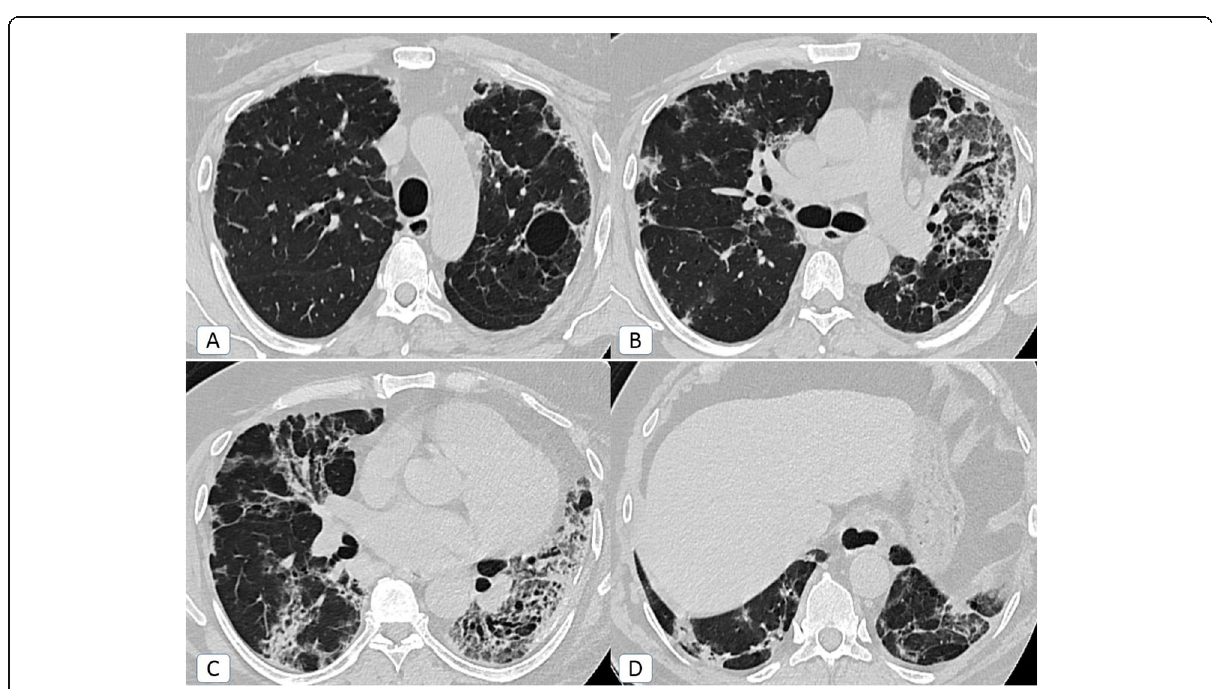
Fig. 3 COVID-19 infection on top of old TB and fibro-thorax: a 55-year-old female COVID-19 patient. A . Axial chest CT (lung window) showing bilateral apical pleural and sub-pleural fibrotic changes, more accentuated on the left side with cystic changes and centrilobular emphysema. B , C Axial chest CT (lung window) showing right upper and lower lobar peripheral located ground glass patches of recent COVID-19 infection. This is together with a diminished volume of the left hemithorax which showed ground glass changes, fibrotic changes with traction bronchiectasis and